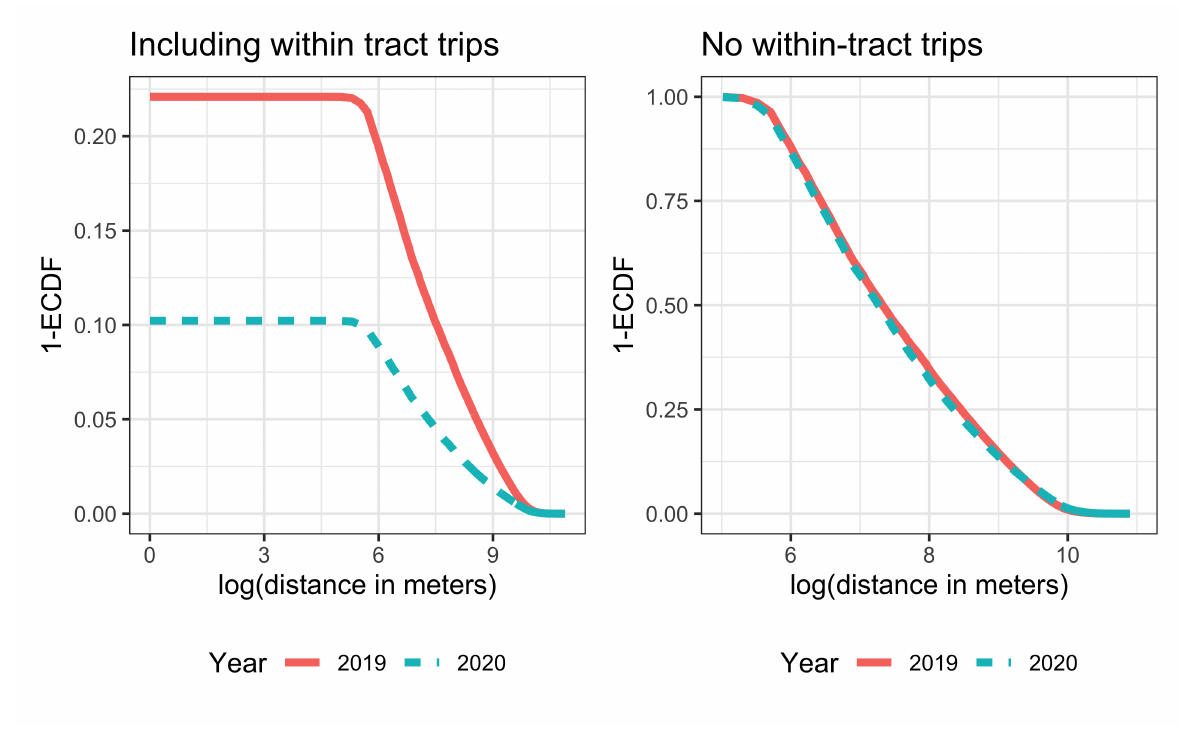
Figure 5: Complementary empirical cumulative distribution function (1-ECDF) of trip distances of tracts during the week of April 7 in New York City. Trips within the home census tract are given a distance of